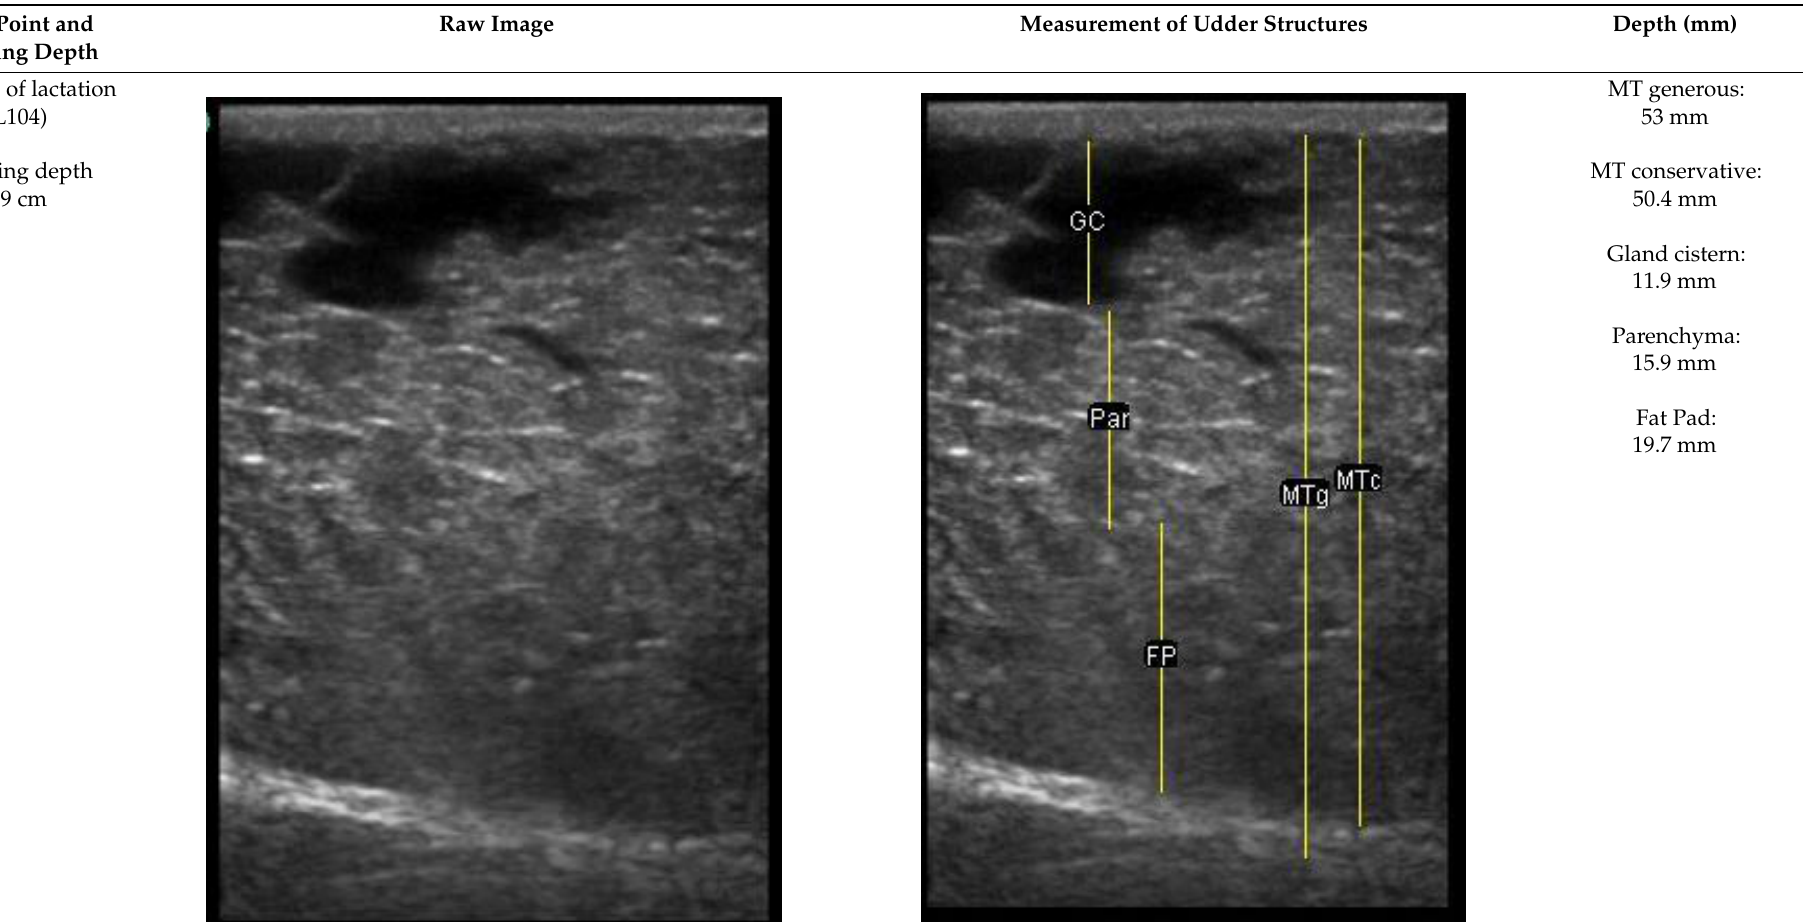
Table A3. Drawing template of mammary ultrasound images at weaning (100 days of lactation; L100) in four different yearling ewes. Time Point and